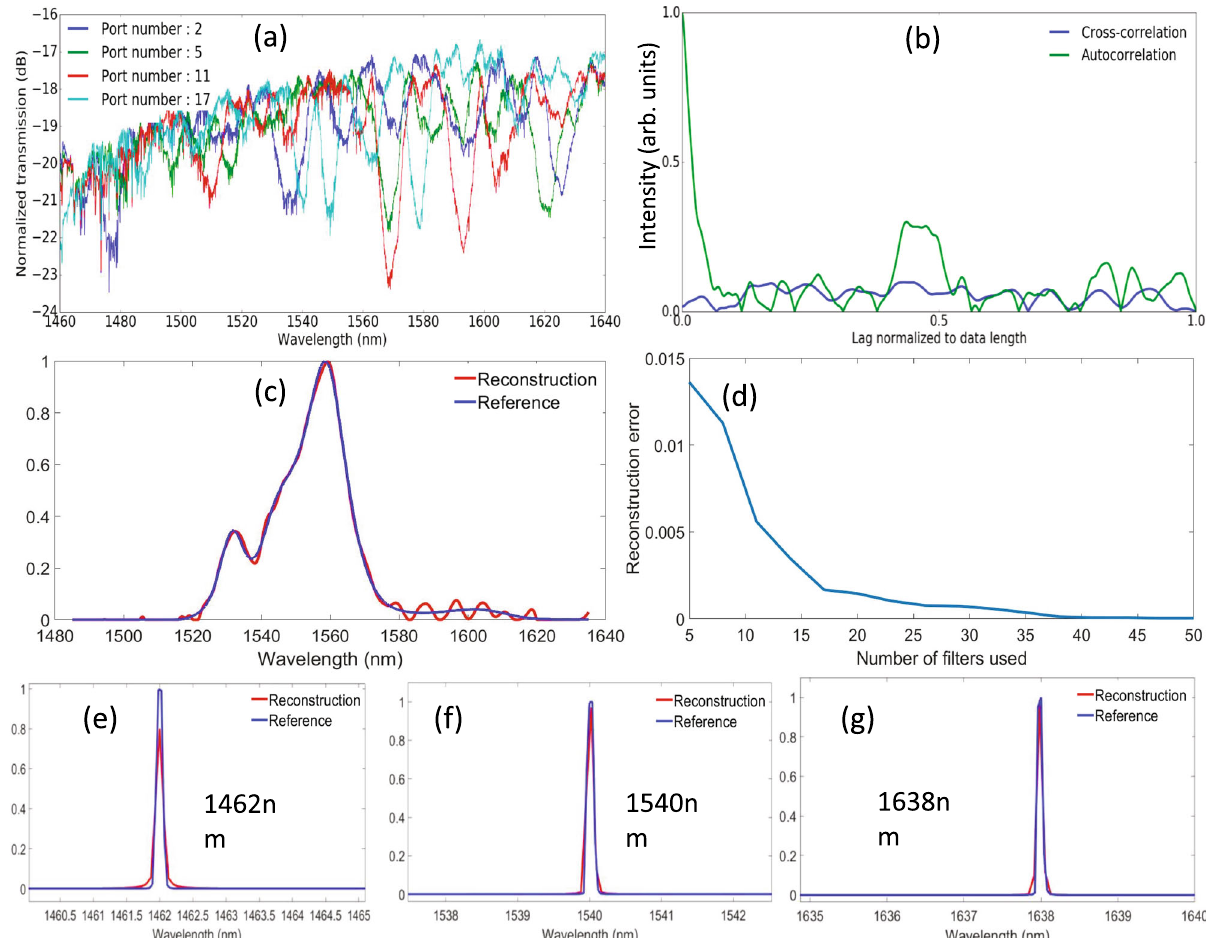
Fig. 4 Experimental validation and characterization of the single-shot SWF-based spectrometer system. a The measured spectra of some SWFs normalized to a straight waveguide transmission. Different colors indicate spectra of different SWFs. b The autocorrelation of a single fi lter measured spectrum (in green) and cross-correlation of two randomly chosen SWFs spectra (in blue). c Reconstruction of a broadband spectrum using the procedure described by Eqs. (4) and (5) (in red) and reference measured by a commercial optical spectrum analyzer (in blue). d Reconstruction errors as a function of the number of fi lters used for the input signal spectrum reconstruction. e – g Reconstruction of the narrowband spectrum in the spectral range of 146 nm to 1640 nm. The FWHM of the resolved peak maintains about 0.45 nm throughout the 180 nm